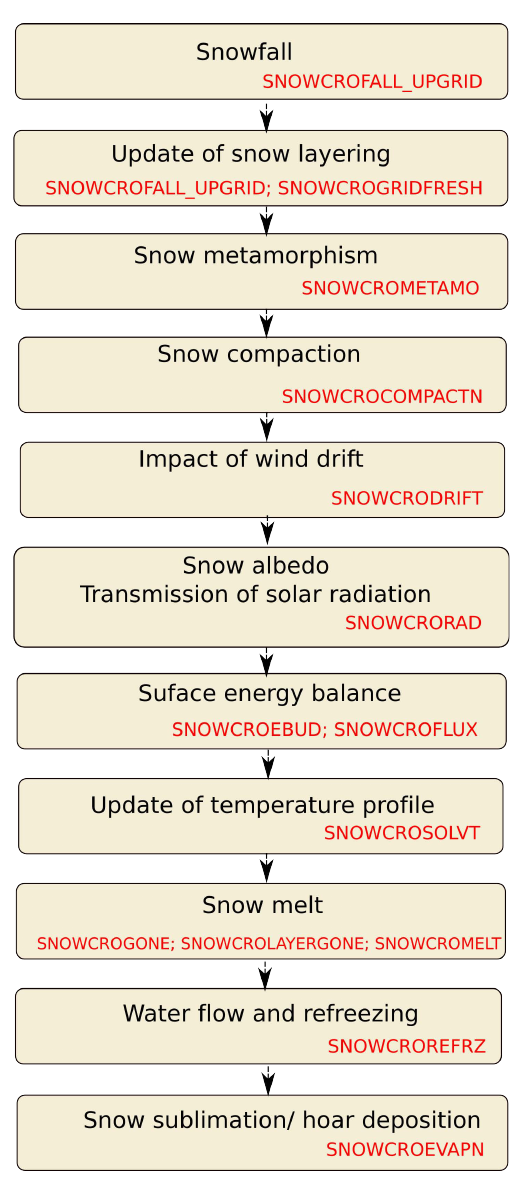
Fig. 2. Flow chart of the routines in